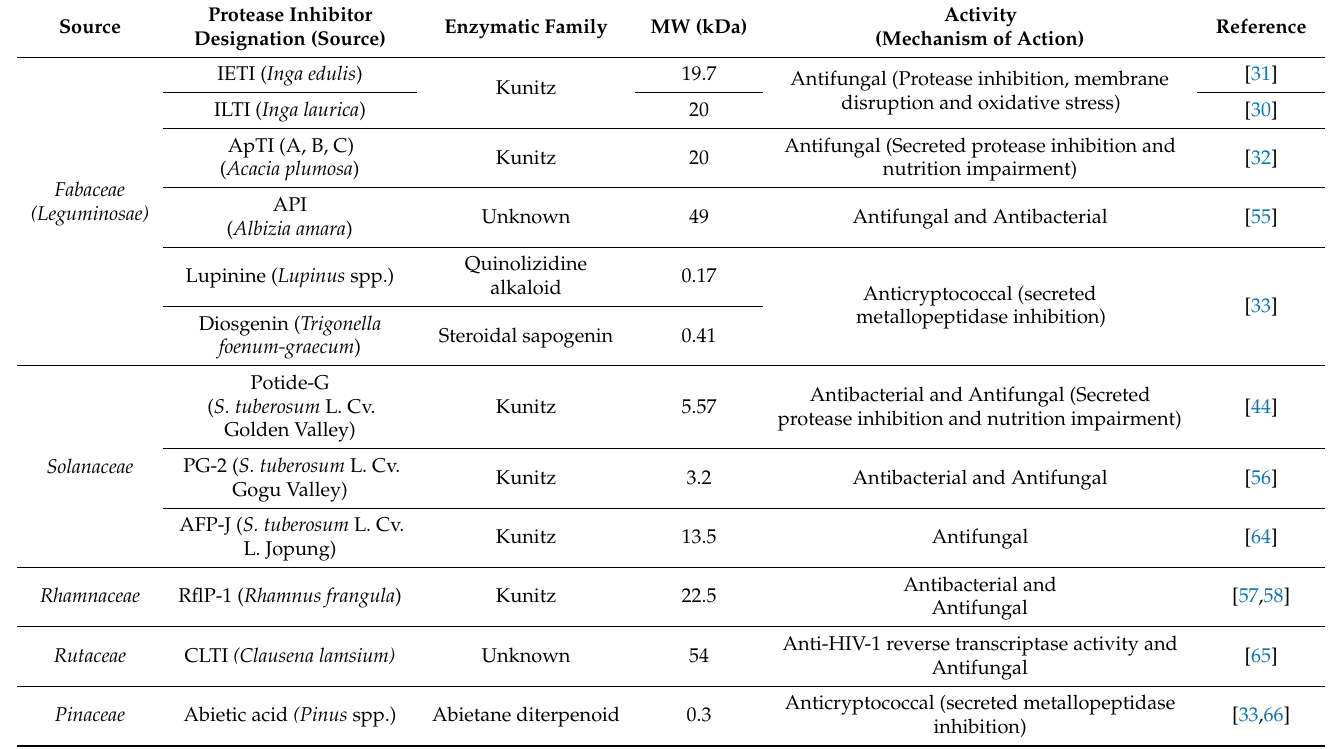
Table 1. Protease inhibitors derived from plants with antimicrobial